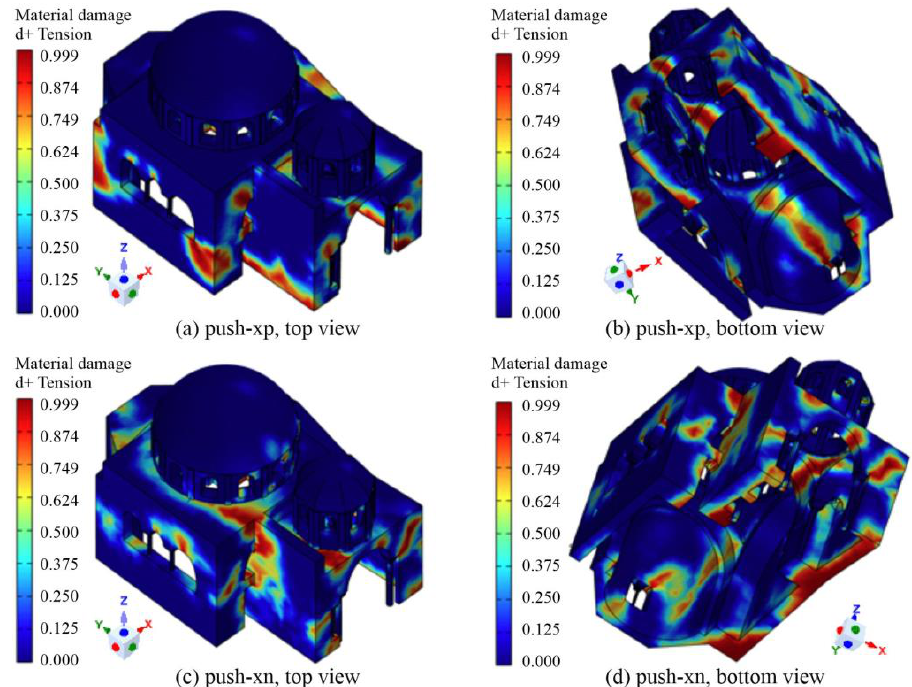
Figure 18. Material damages in the main structure under push-xp and push-xn loadings.